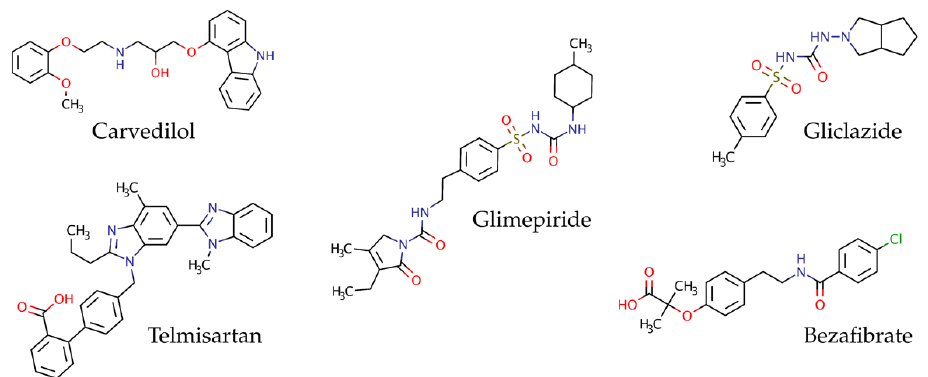
Figure 1. Chemical structures of active pharmaceutical ingredients (API) for the treatment of hypercholesterolemia (BZT), type II diabetes (GZD and GMP) and hypertension (CVD and TEL).